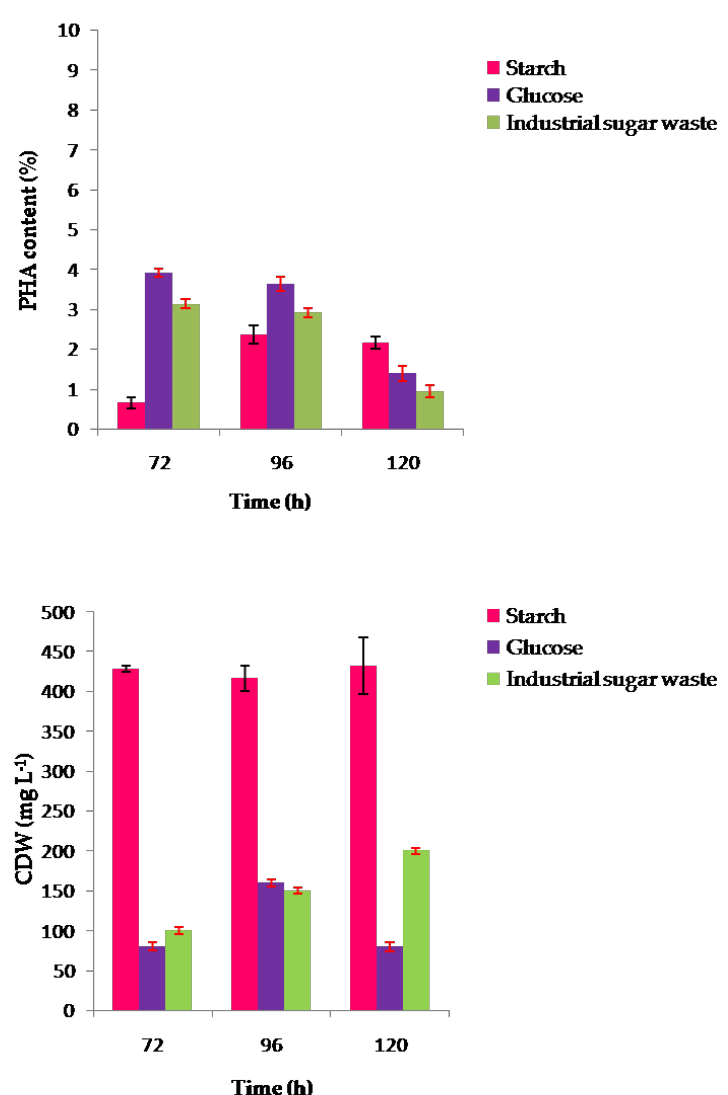
Figure 5. E ff ect of di ff erent carbon sources on CDW (mg L − 1 ) and PHA content (wt %) of the strain CEJEA36 in a medium containing 20 g L − 1 of starch or 20 g L − 1 of glucose or 10 g L − 1 of industrial sugar waste under optimal cultivation conditions: pH, 7; temperature, 37 ◦ C; Concentration of sodium Figure 5. Effect of different carbon sources on CDW (mg L −1 ) and PHA content (wt %) of the strain chloride, 25% upon 72 h, 96 h, and 120 h. CDW: cell dry weight, PHA: polyhydroxyalkanoate. Data are presented as means of duplicate with their standard errors. PHA content in dried cells was analyzed CEJEA36 in a medium containing 20 g L −1 of starch or 20 g L −1 of glucose or 10 g L −1 of industrial by gas sugar waste under optimal cultivation conditions: pH, 7; temperature, 37 °C; Concentration of sodium chloride, 25% upon 72 h, 96 h, and 120 h. CDW: cell dry weight, PHA: